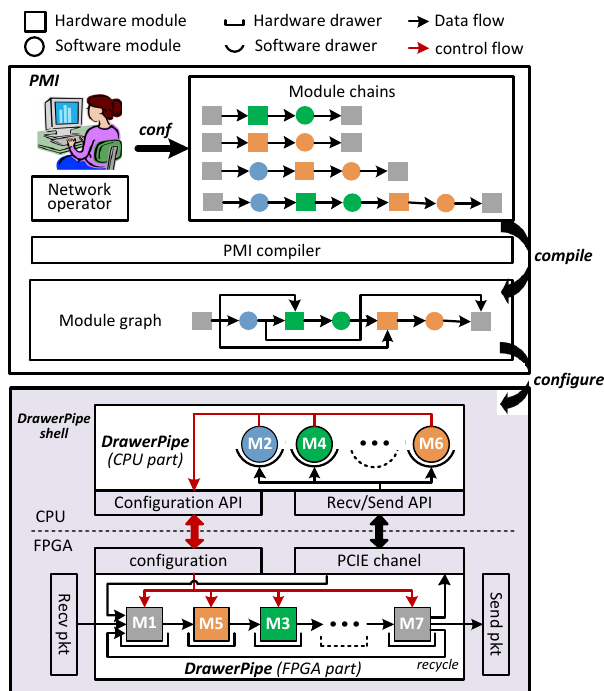
Figure 4. NF developers write scripts to describe module chains, which are compiled into a module graph for constructing and configuring the packet processing pipeline based on